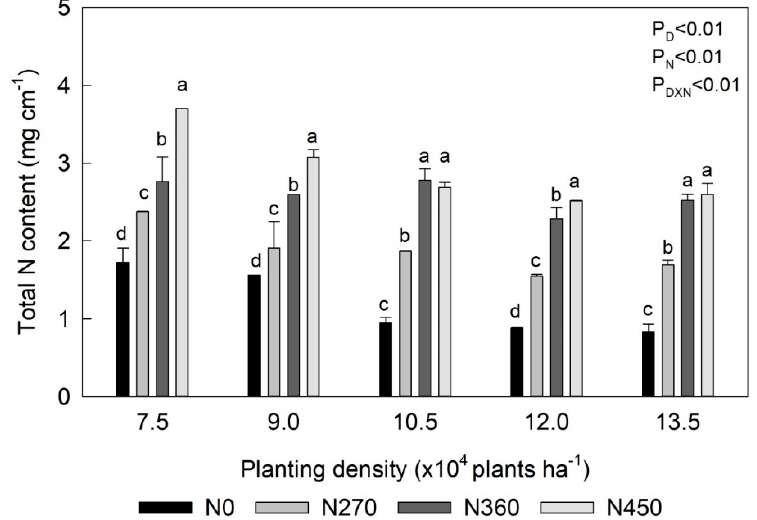
Figure 6. Effect of nitrogen application rate on the N content of the basal third internode of maize under drip irrigation for different planting densities (year 2018).